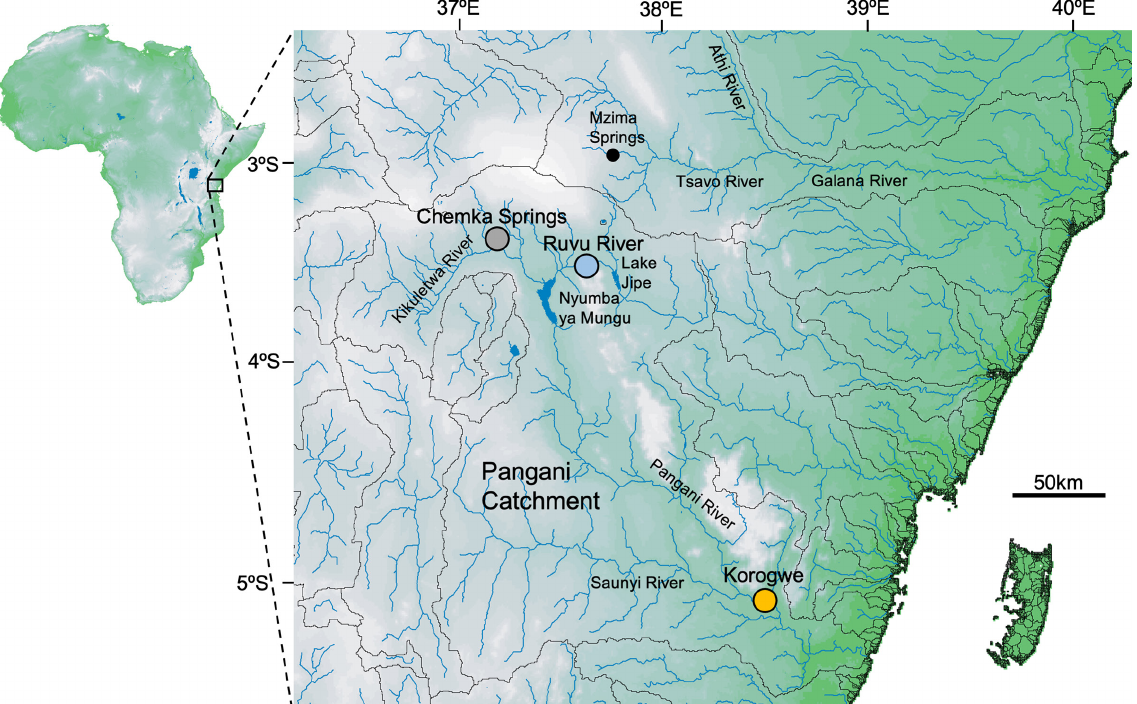
Fig. 1. The type locality of Ctenochromis pectoralis Pfeffer, 1893 is Korogwe, in the lower section of the Pangani River system. Collection sites of specimens of Ctenochromis for this study were Chemka Springs and the Ruvu River (which flows between Lake Jipe to the east, and Nyumba ya Mungu Reservoir to the west). A further population of Ctenochromis has been reported from Mzima Springs, in the Tsavo River system of